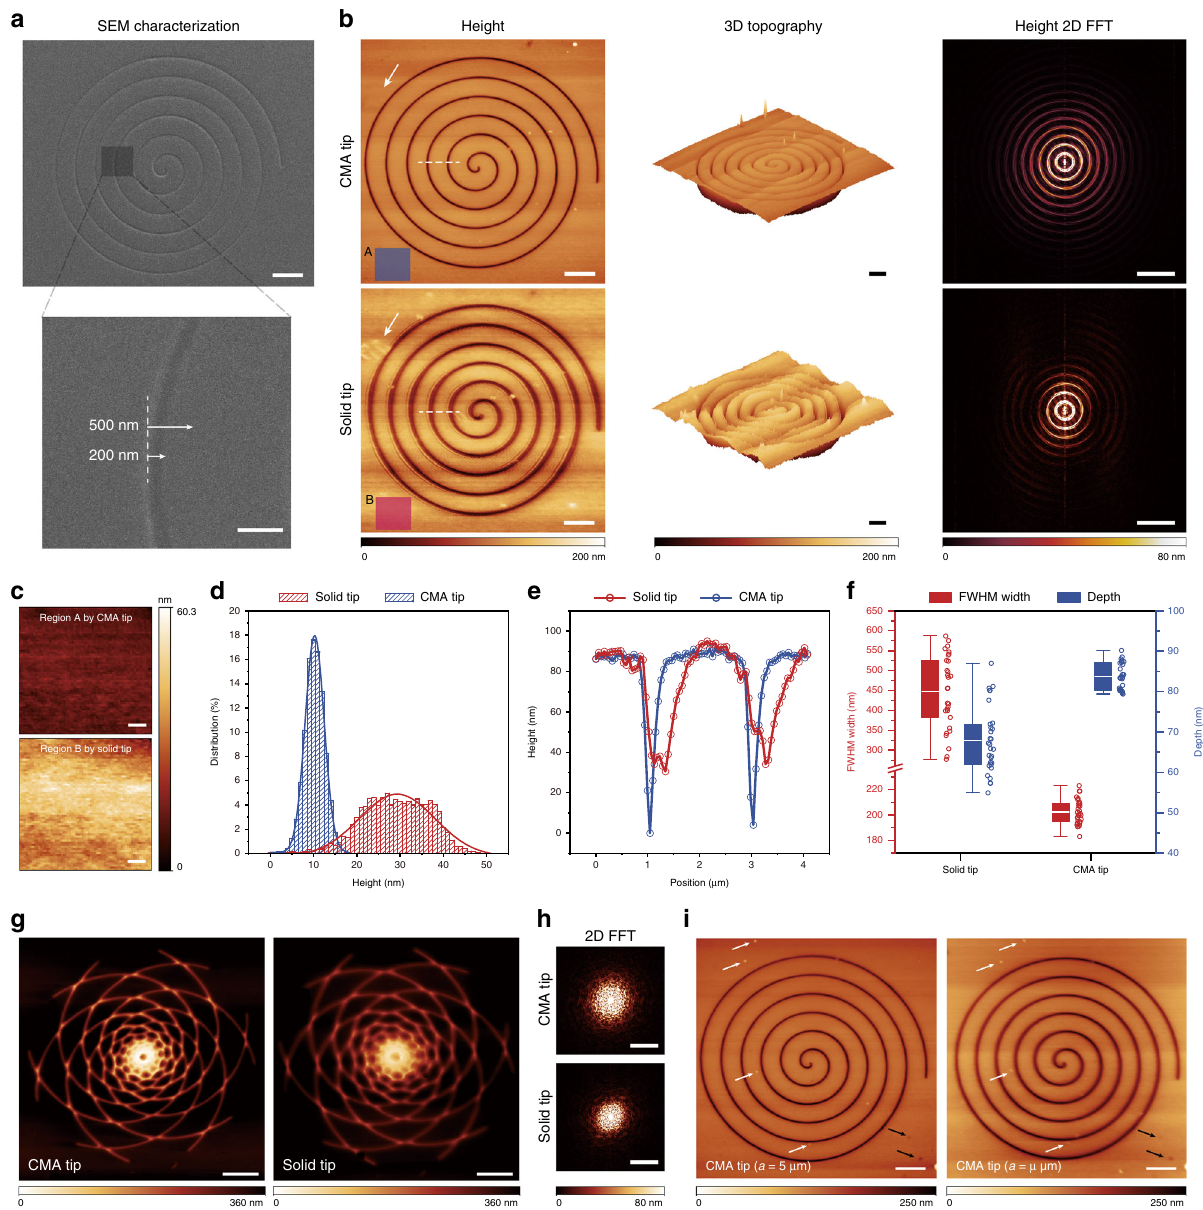
Fig. 4 AFM imaging of PDMS patterns with CMA tips. a SEM images of PDMS spiral patterns molded from the DLW 2D template (Supplementary Fig. 7c). The lengths of the white pointed lines in the SEM image represent physical distances of 200 nm and 500 nm, respectively. Scale bars are 3 μ m and 500 nm for upper and lower images, respectively. b Scanning images respectively acquired by the CMA tip ( a = 5 μ m) and the solid tip (DLW solid cone) with images from left to right respectively corresponding to 2D height plots, 3D topographies, and 2D fast Fourier transformation (2D FFT) images of the height plots using a Hanning window. The same color bars are used for height, 3D topography, 2D FFT images, respectively. Scale bars are 3 μ m for height and 3D topography images and 3 μ m -1 for 2D FFT images. c Magni fi ed surface details (scale bar is 500 nm) separately extracted from region A and B in the height plots of b . d Histogram analysis of interfacial landscape in c showing frequency counts (1 nm step) of height distribution. The histograms are fi tted with Gaussian curves. e Height pro fi les along the white dash lines in b . f Boxplots of FWHM width and depth of the groove measured by the solid tip and CMA tip in b . The Boxplot marks the median (center line within box), the fi rst and third quartile (box), and 1.5 times the interquartile range (whiskers). The corresponding data are exhibited as scatter plots on the right side of each box. g , h Height pro fi le ( g ) of a fl ower pattern (Supplementary Fig. 7d, e) and the corresponding 2D FFT images ( h) obtained by the CMA tip ( a = 5 μ m) and the solid tip (DLW solid cone) at a decreased setpoint value. i Imaging comparison using CMA tips with different unit side lengths ( a = 5 μ m and 2 μ m). The surface grains are indicated with white and black arrows. Scale bars are 3 μ m for g , i and 3 μ m -1 for h . Source data of d – f are provided as a Source Data fi upper image displays a more uniform result while the other one of 10.3 nm and an RMS (root mean square) roughness of 2.2 nm. features a discrete distribution with violent fl uctuations, especially By contrast, the presented surface image by the solid tip manifests along the slow scanning axis. According to the height histogram a dispersed distribution widespread over a range of 51 nm with an described in Fig. 4d, the CMA tip scanned surface image displays a average height value of 29 nm and an RMS roughness of 7.6 nm. range of 18 nm in height distribution, possessing an average value Theoretically, in the ideal situation, the exerted stress from the tip